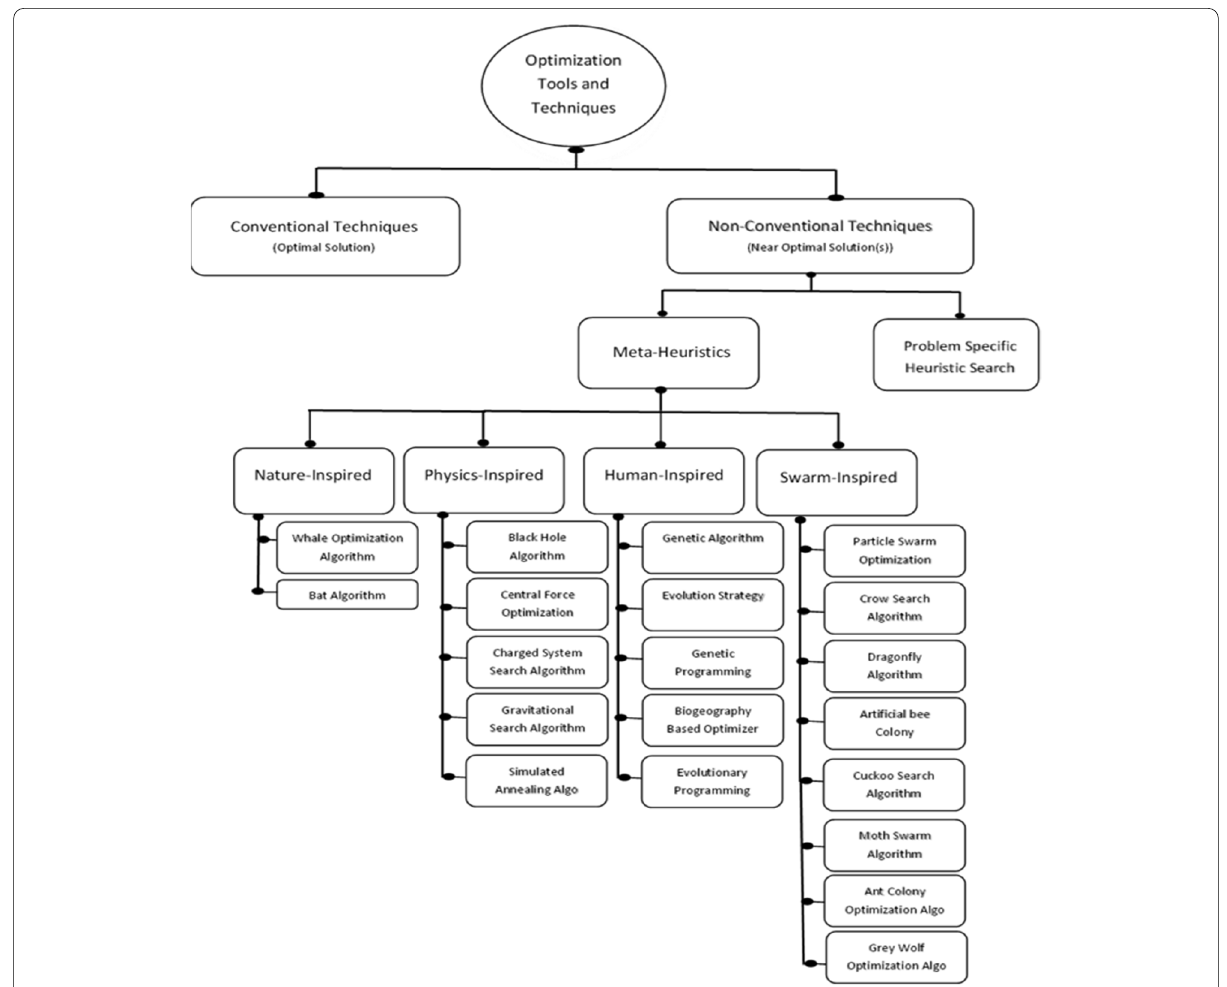
Fig. 1 Classification of Meta-Heuristic